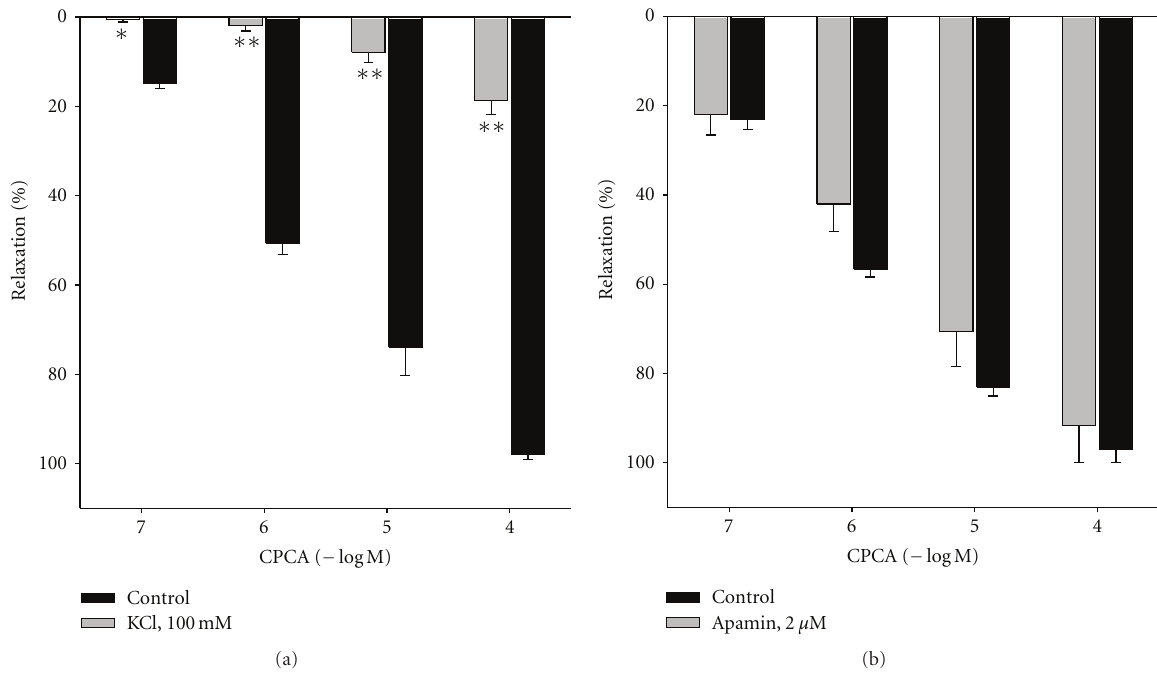
Figure 4: CPCA-induced relaxation in isolated rat femoral artery in the presence of hyperpolarizing solution (KCl = 100mM) or apamin. Each point represents the mean ± SEM. ( n = 5–7). Vascular relaxations induced by CPCA are expressed as percentages of the precontraction induced by phenylephrine. ∗ P < 0 . 05 and ∗∗ P < 0 . 01 compared to the control relaxant e ff ect ( n = number of